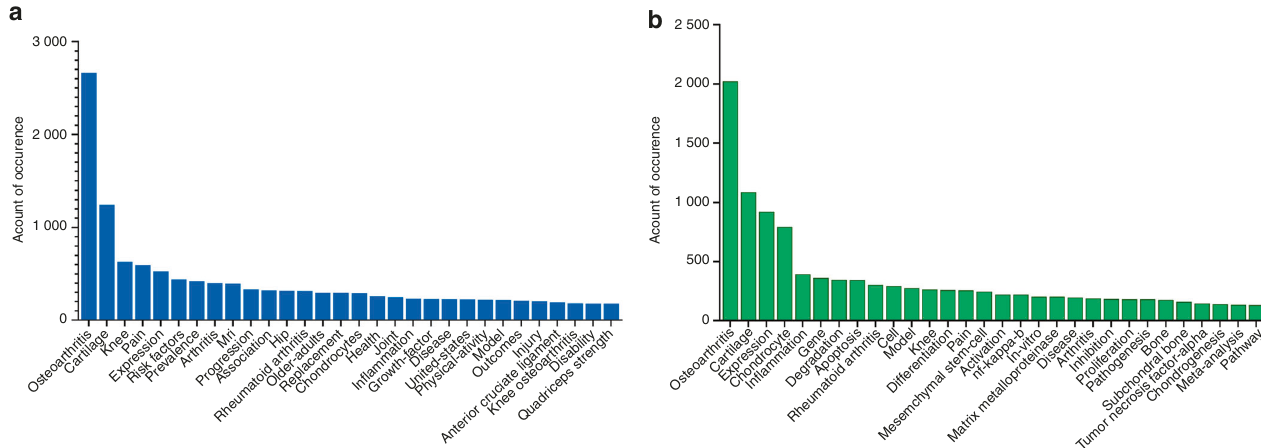
Fig. 6 The distribution of the top 30 keywords in the publications supported by the NIH or NSFC. a The distribution of the top 30 keywords in the publications supported by the NIH. b The distribution of the top 30 keywords in the publications supported by the